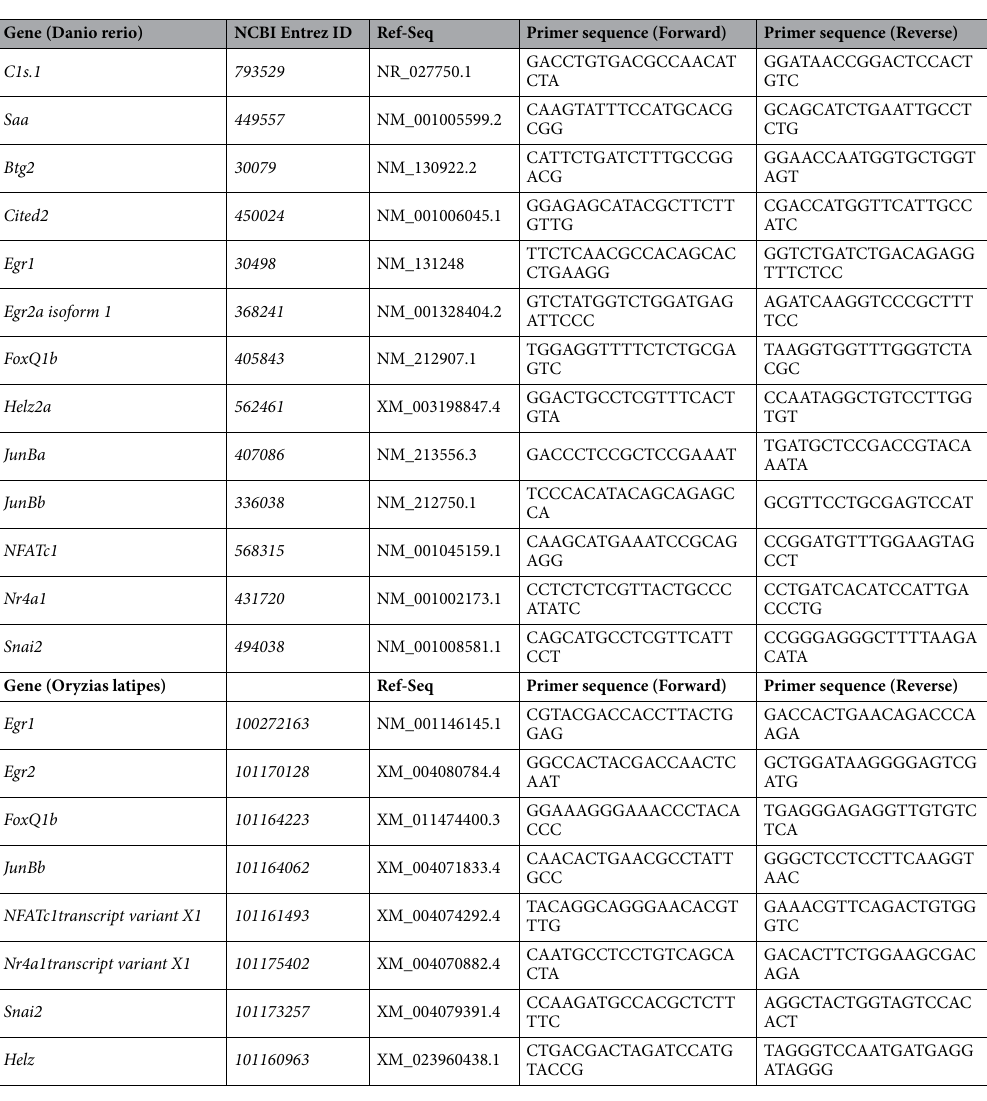
Table 3. Primer sequences for